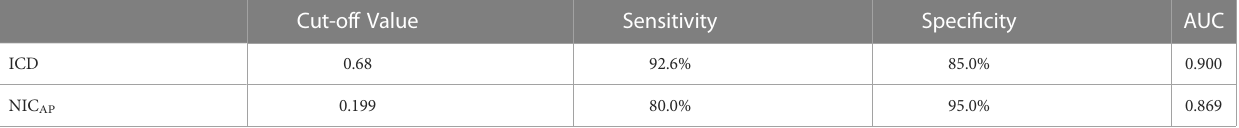
TABLE 3 Iodine difference and NIC AP to identify the results of ROC curves on the dominant and non-dominant side.